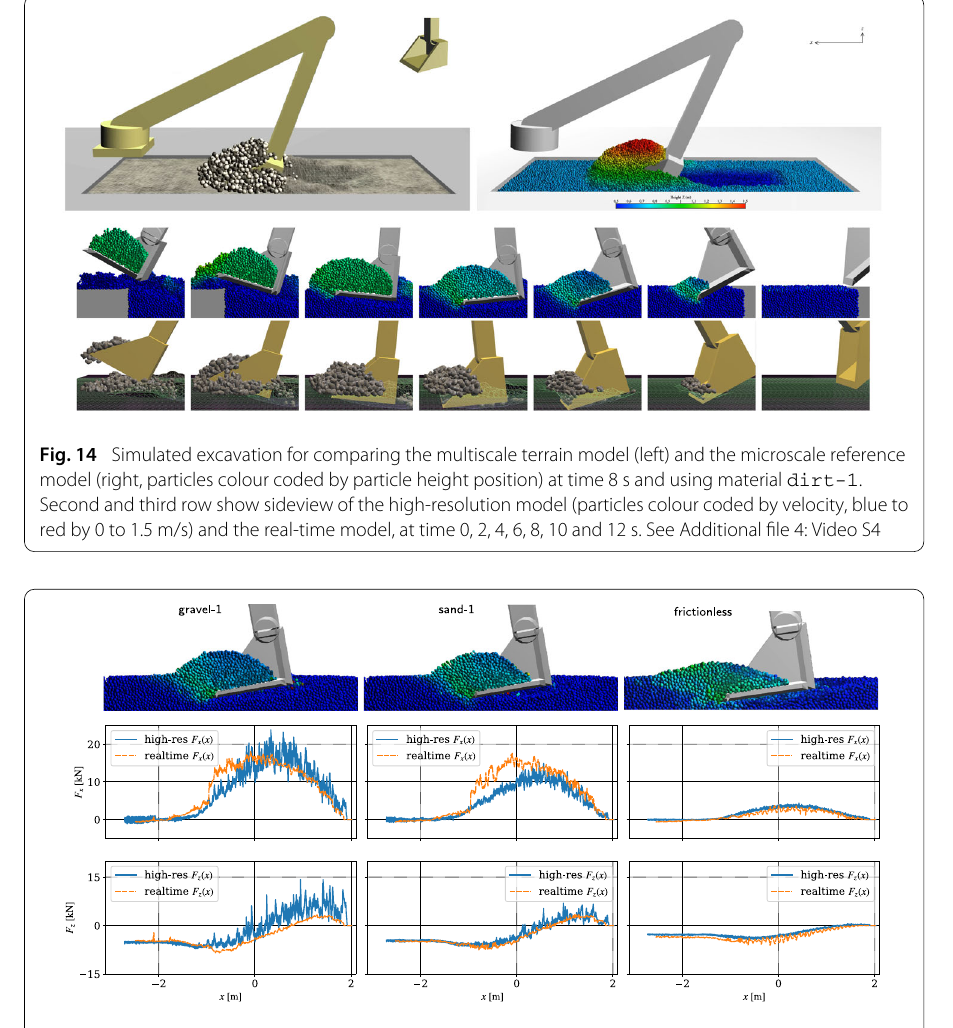
Fig. 15 Force resistance from excavation using three frictional soils and the microscale model, with snapshot taken at 5